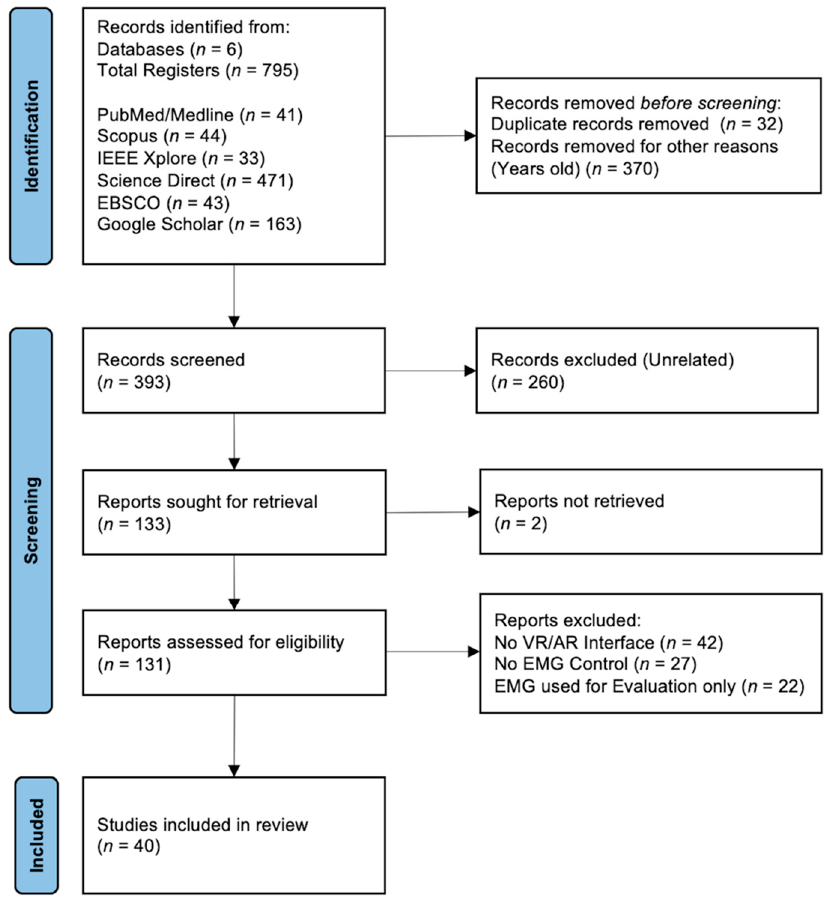
Figure 1. PRISMA flow diagram for the systematic literature review.